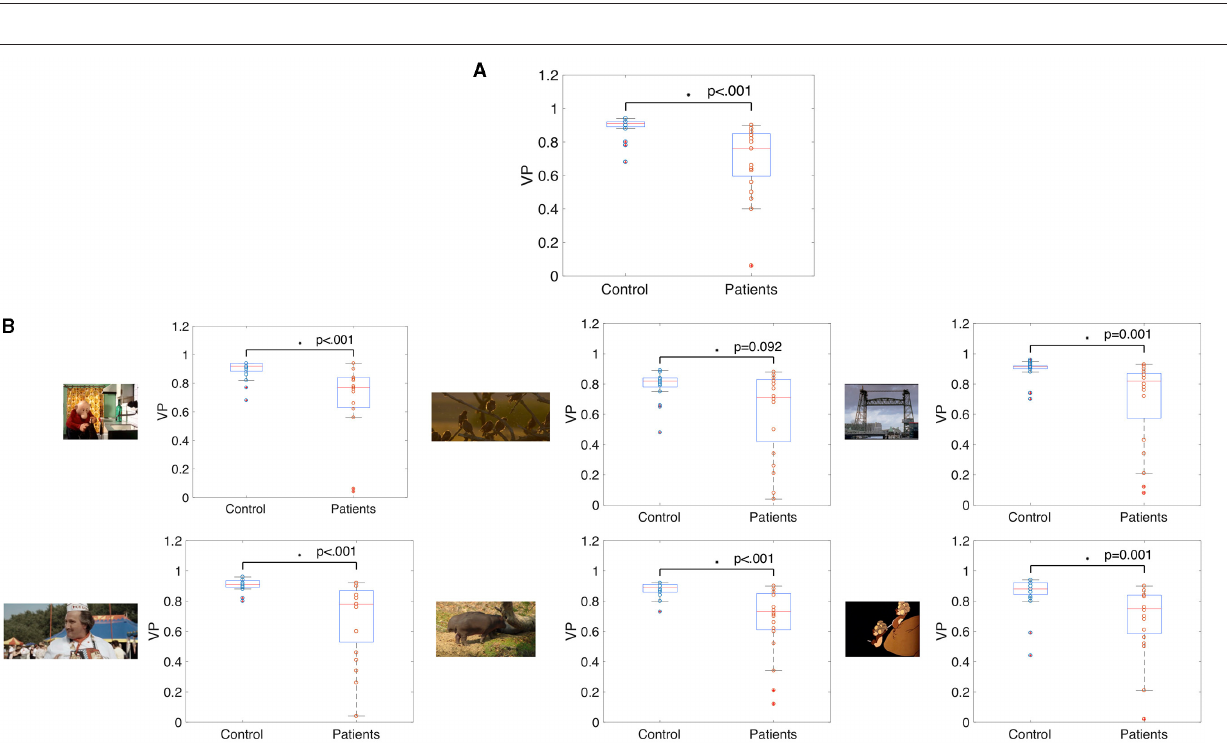
FIGURE 2 | saccade amplitude in 18 different directions for individual patients, connected with a blue line. For comparison, we also show the saccade amplitudes of the control group. The scattered red line represents the minimum and the maximum of the saccade amplitudes of the control participants per direction. The figure on the right shows, in terms of saccade amplitude per direction, the normalized rank of the saccades of the patient amongst those of the controls. Red lines represent the boarders at which the rank is above or below the upper and lower 2.5% of the control group. In the fourth column, the figures show the same for the maximum saccade amplitude. (A) Patients with peripheral visual field loss in the tracked eye. The first two patients have large VFD in their covered eyes. (B) Patients with a nasal arc or other small VFD, which were closer to the center than the VFD of the patients in the first group. (C) Patients with VFD that approximate tunnel vision in the tracked eye. (D) Patients with large VFD in various parts of the visual field. (E) Patients who are almost blind. (F) Patient, with an intact visual field of the tracked eye.